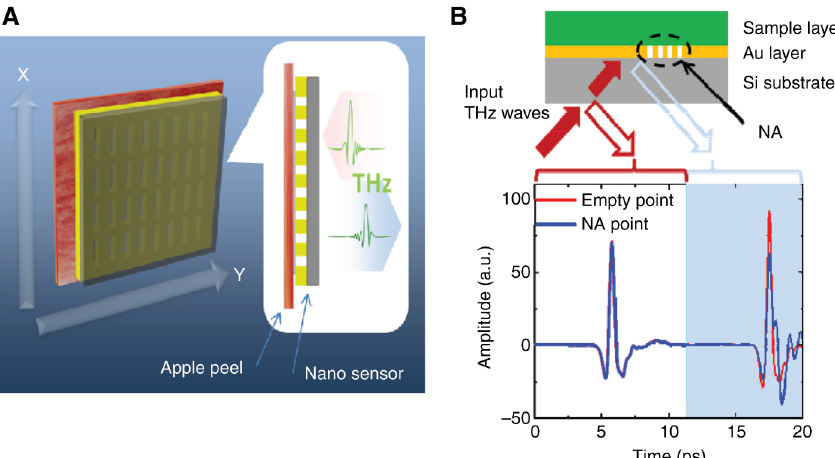
Figure 6: (A) A schematic image of a sensing chip contacting to the apple peel sample that was partially contaminated by a dropping of pesticide. (B) A schematic of THZ reflection configuration for multilayered samples and measured re-